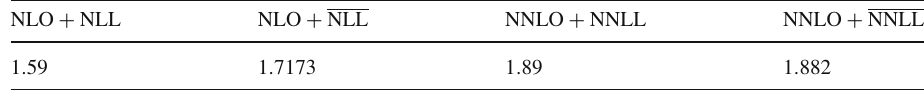
Fig. 3 Scale variation of the SV and NSV resummed results against the fixed order w.r.t the renormalisation scale( μ R ) in the first panel and factorisation scale( μ F ) in the second panel at 13 TeV LHC